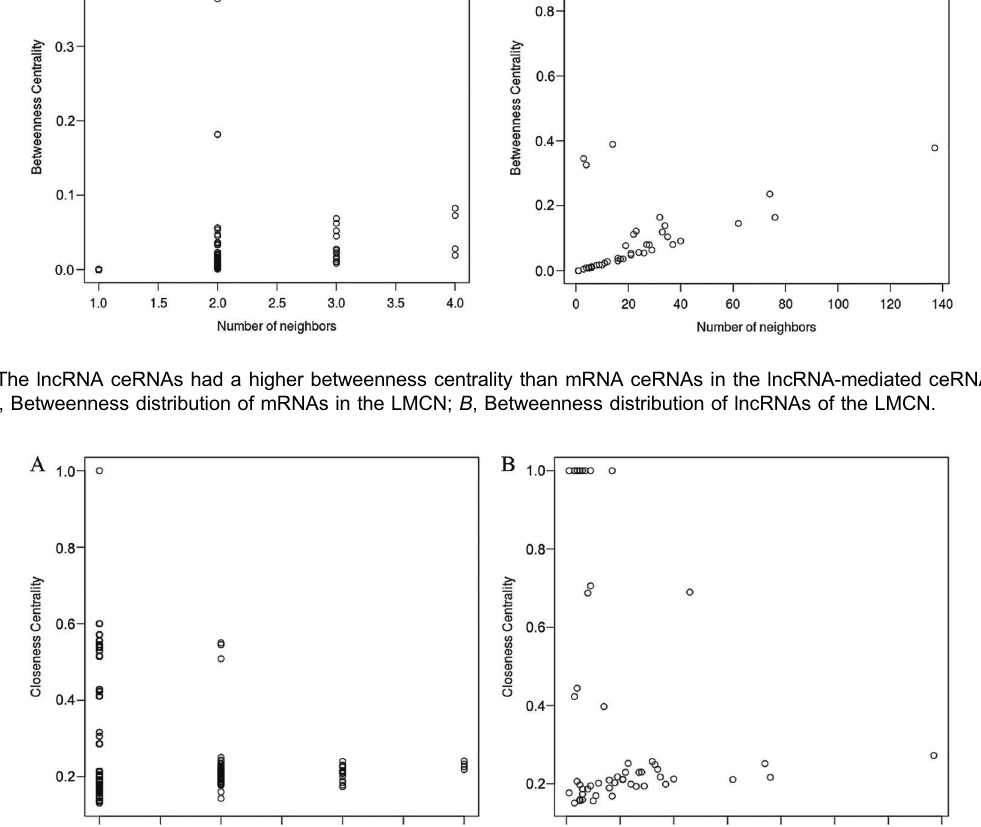
Braz J Med Biol Res | doi: